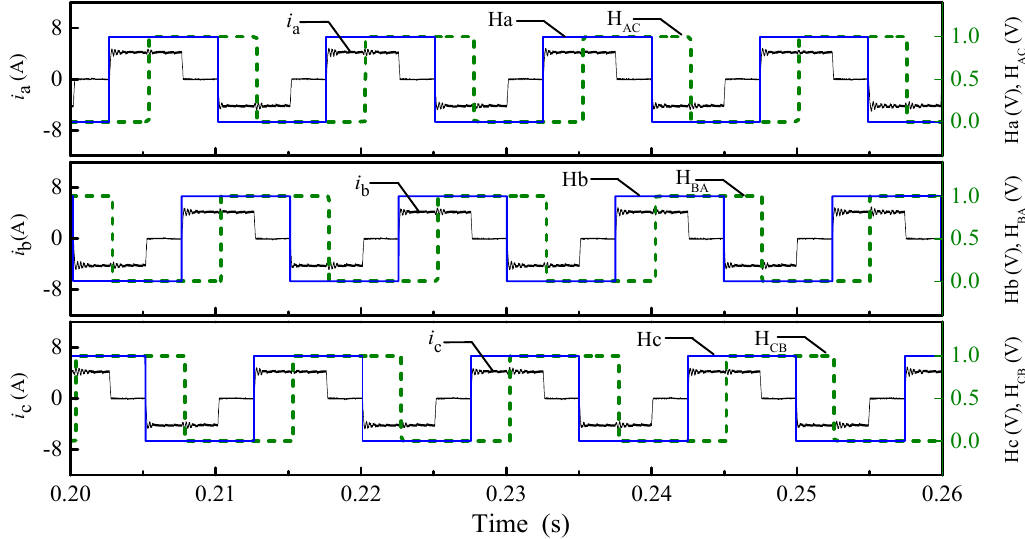
Figure 15. Stator current waveform, Hall signal and compensated digital position signal ( n = 500 rpm).